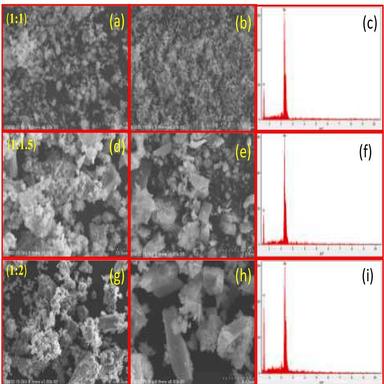
SEM images and EDAX of MoO3 nanoparticles prepared at 1:1(a,b,c) , 1:2 (d,e,f), 1:3 (g,h,i).